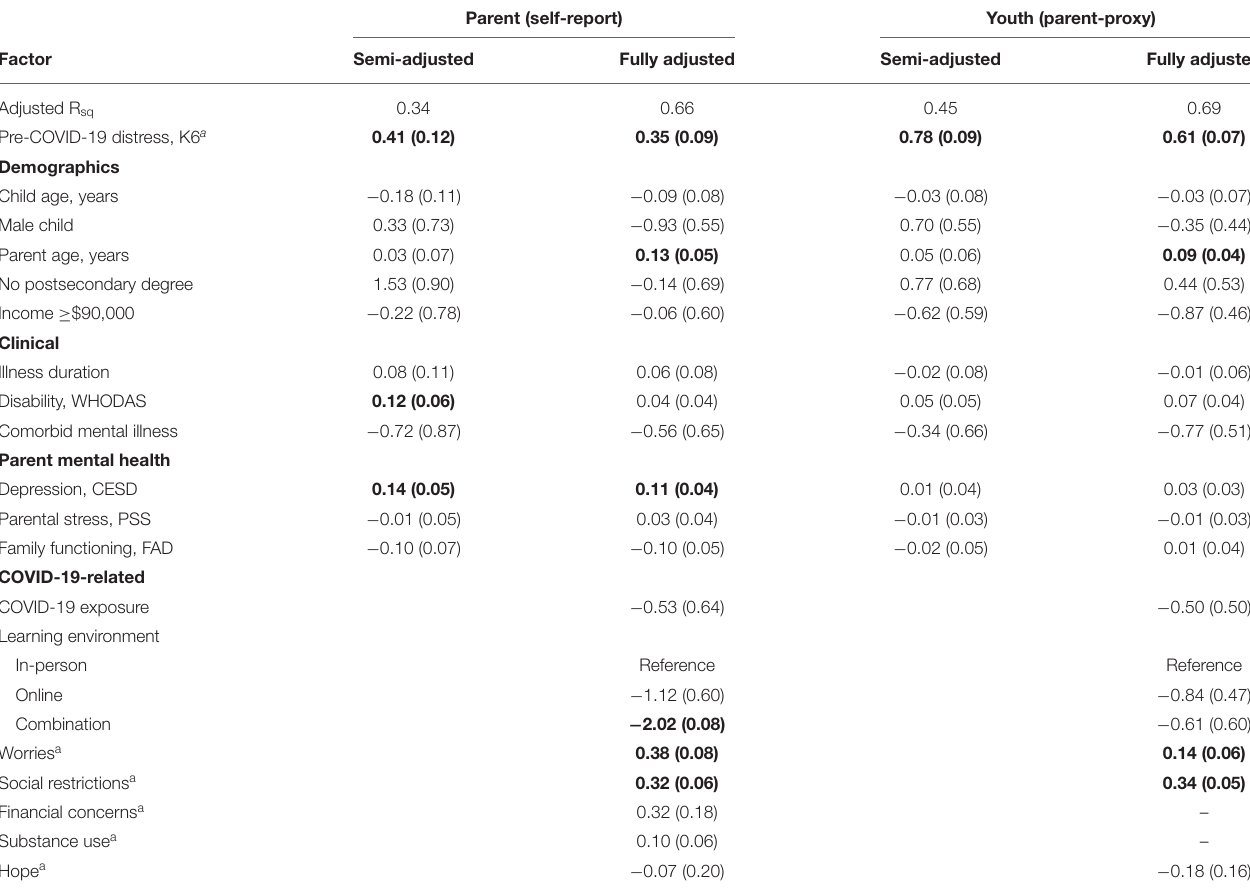
TABLE 4 | Factors associated with parent and youth psychological distress